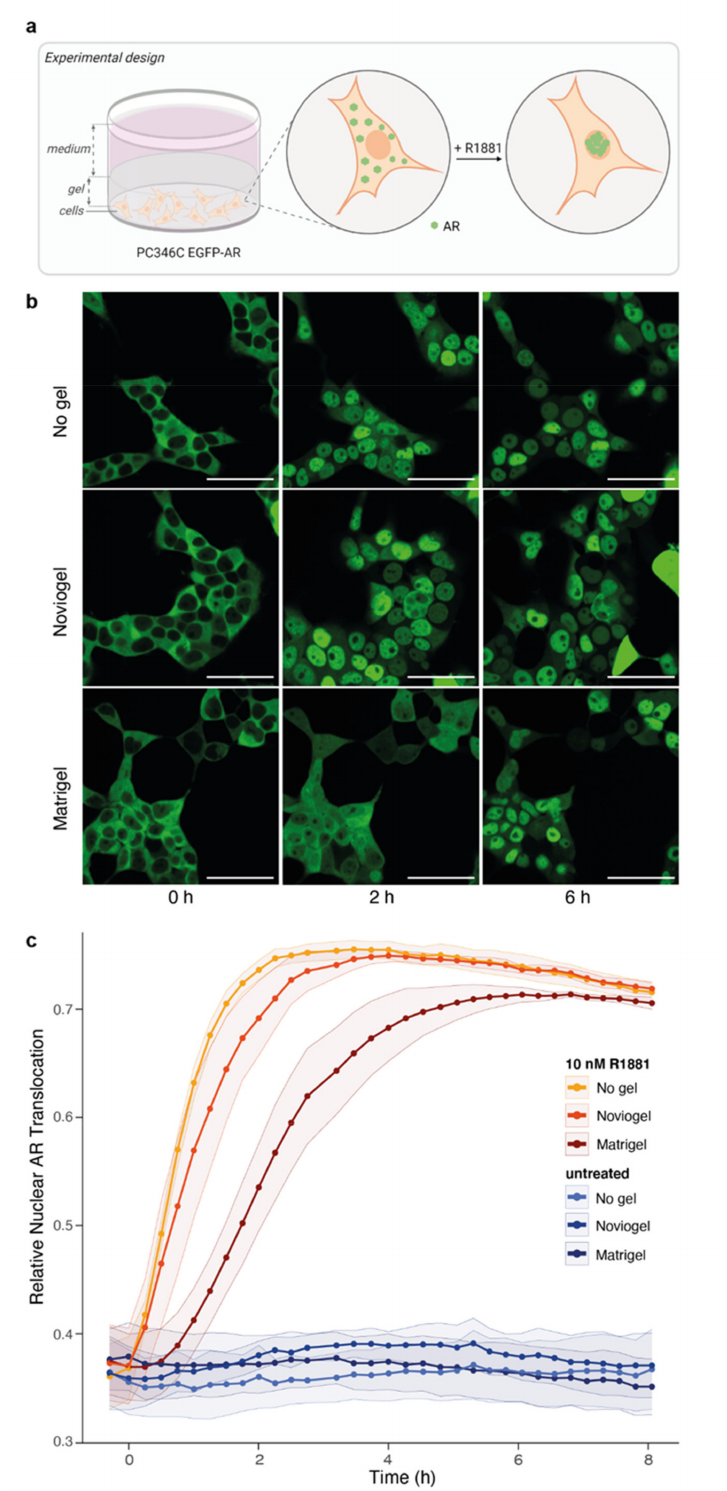
Figure 2. Impact of scaffolds on androgen-induced AR translocation. ( a ) Schematic representation of experimental design. EGFP-AR: enhanced green fluorescent protein (EGFP) labelled AR. ( b ) Representative images of PC346C EGFP-AR monolayers not covered with scaffold (no gel, top panel), covered with synthetic scaffold (Noviogel, middle panel) or covered with Matrigel (bottom panel) at 0, 2 or 6 h after the addition of synthetic androgen (10 nM R1881). Scale bars represent 50 µ m. ( c ) Image-based quantification of nuclear AR translocation in cells not covered with scaffold (no gel, yellow), covered